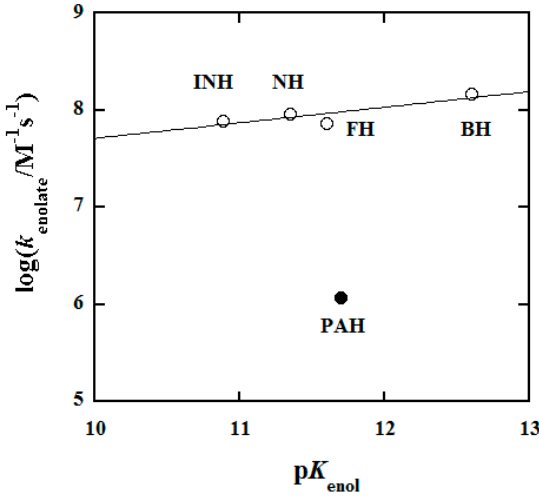
Figure 9. Plot of log k enolate versus p K enol in the oxidation reactions of hydrazides by [IrCl 6 ] 2 − in aqueous solution at 25.0 °C and μ = 1.0 M. INH, NH, FH, and BH are aryl hydrazides.